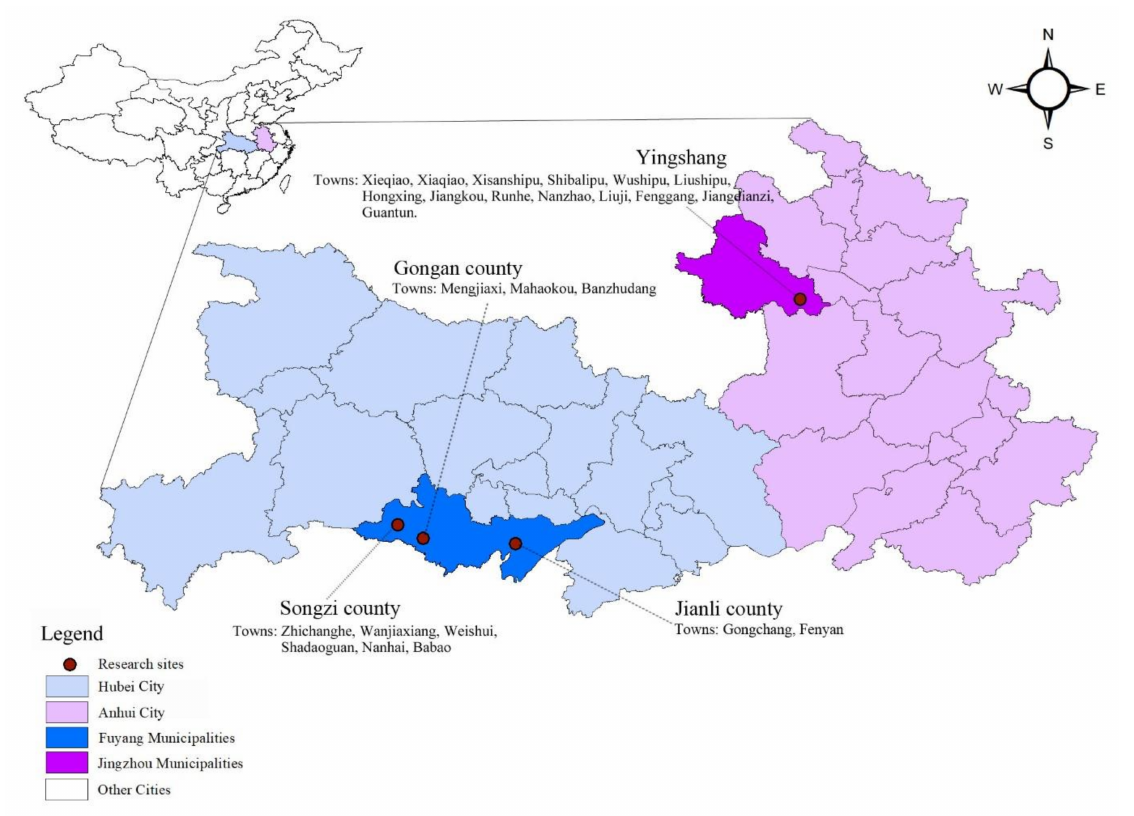
Figure 2. Location of study